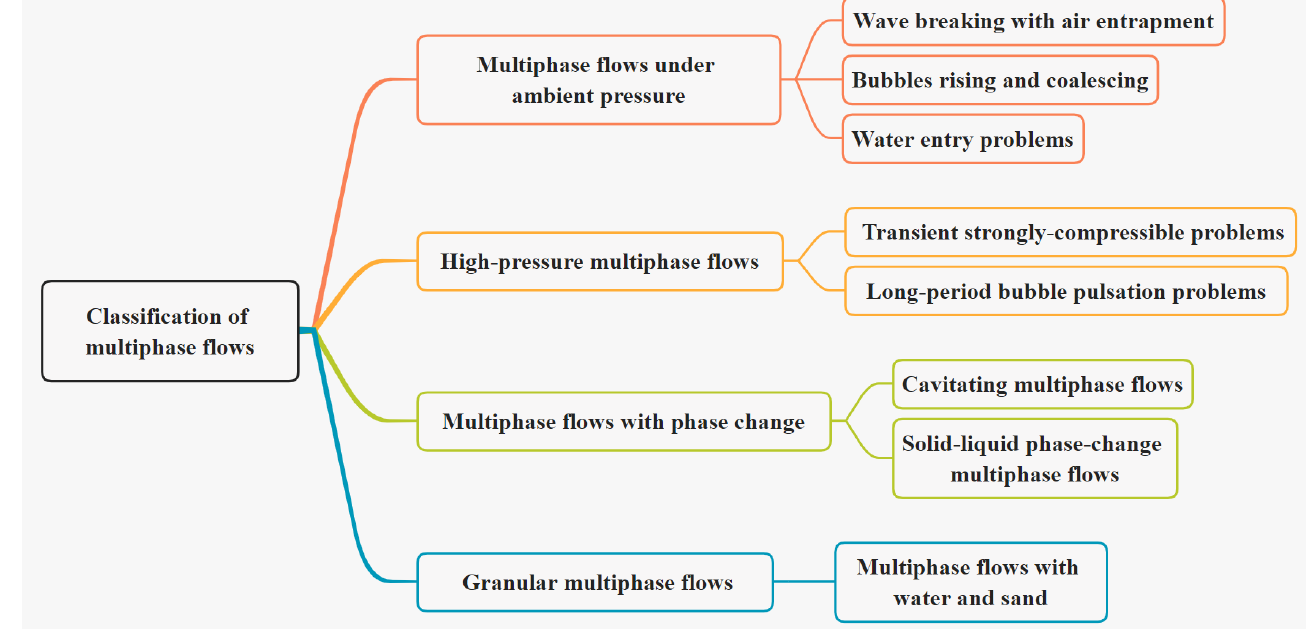
Figure 1. The typical multiphase flow problems reviewed in this